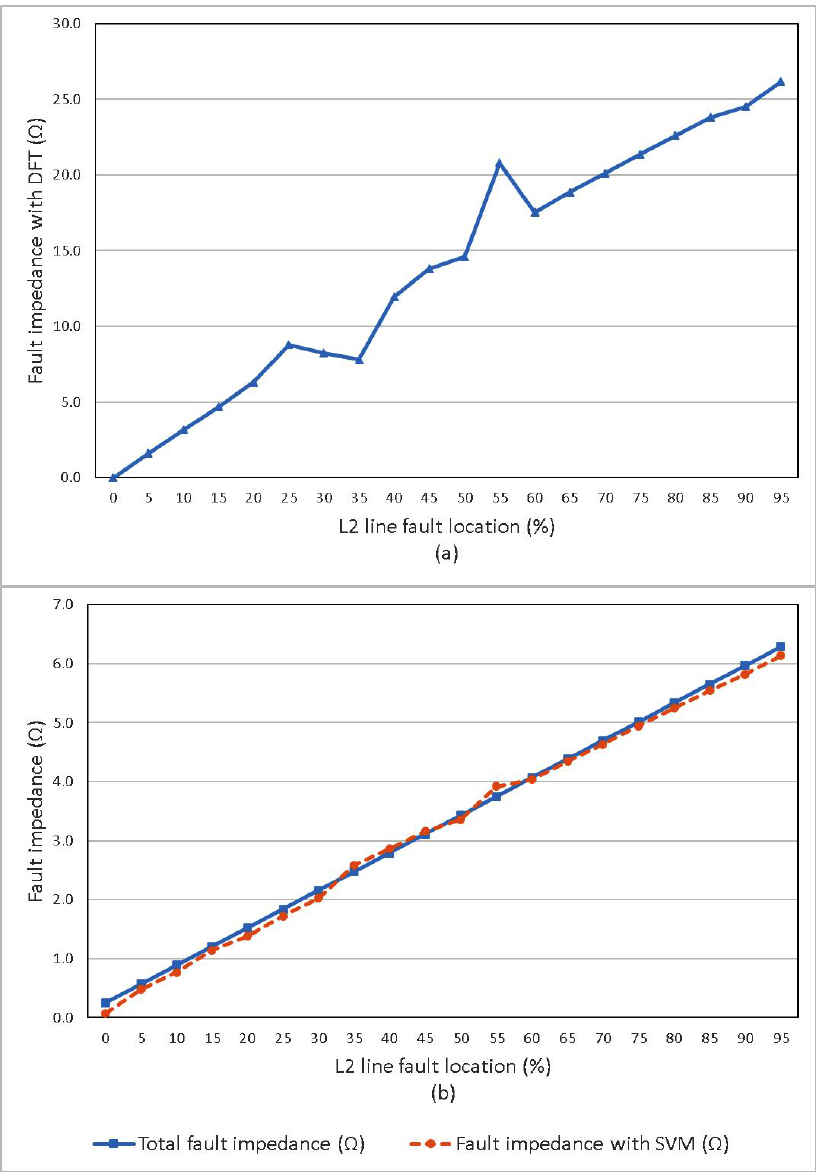
Figure 13. Phase–phase faults. ( a ) Fault impedance with DFT-fault location. ( b ) Total fault impedance and fault impedance with SVM-fault location. Table 4. Impedance-fault locations for phase–ground